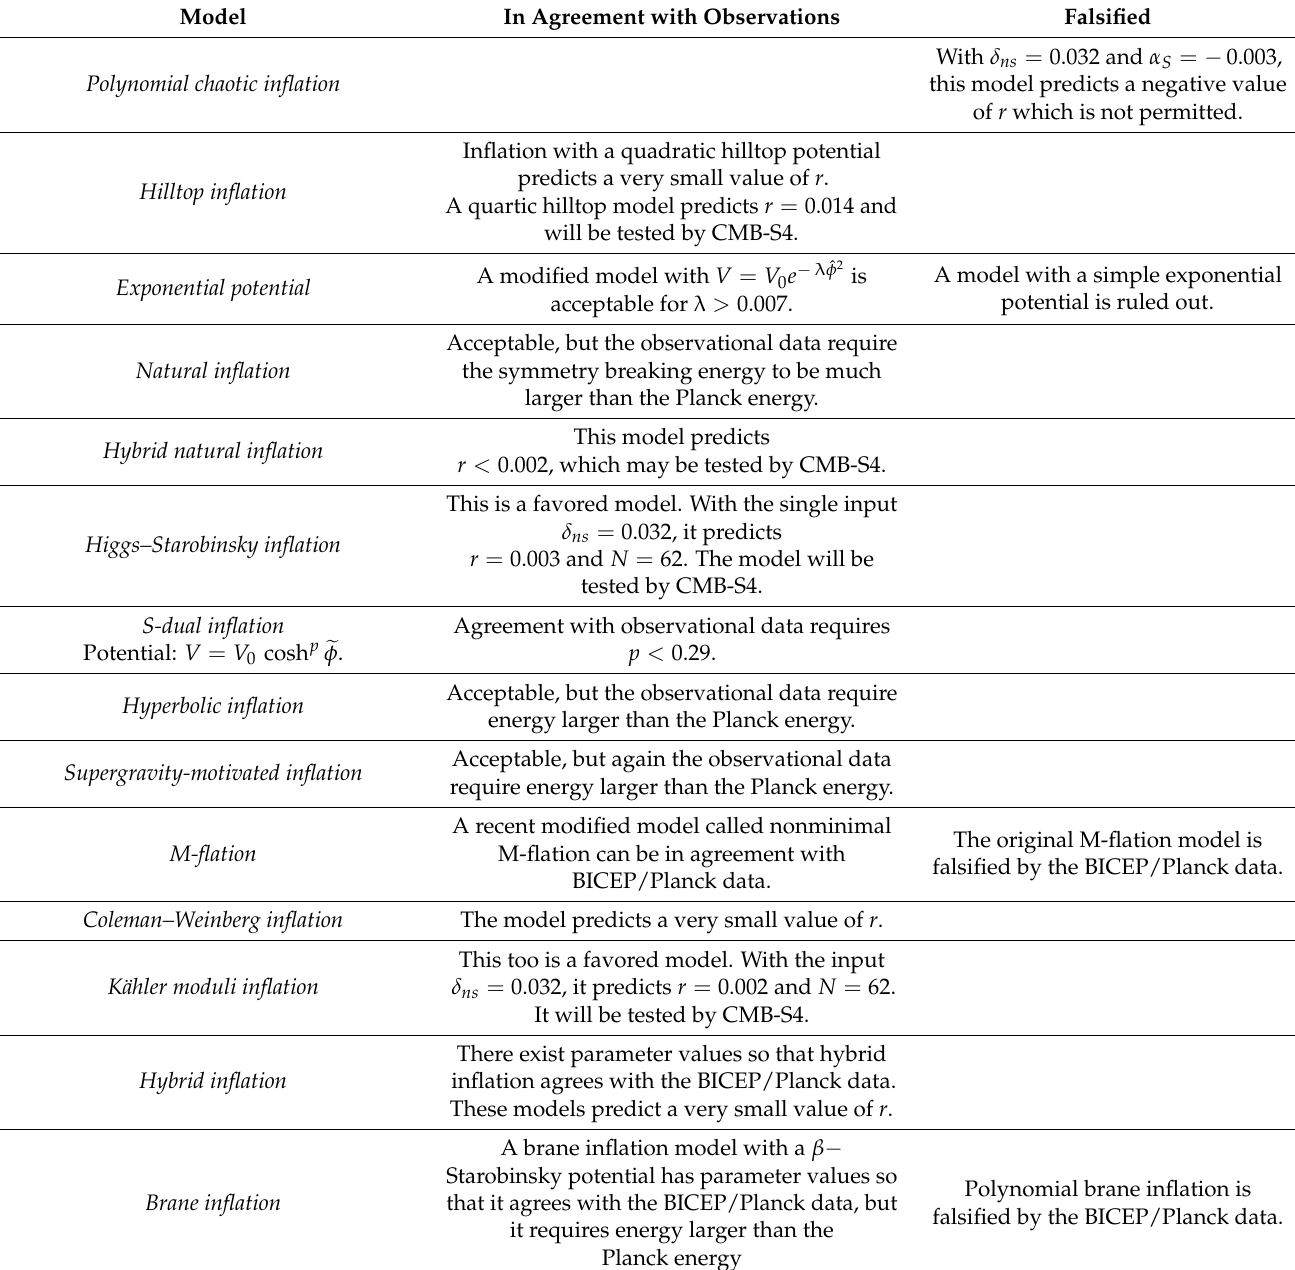
Table 1. Results of confronting predictions of the tensor-to-scalar ratio by inflationary universe models with the most recent BICEP/Planck and future CMB-S4